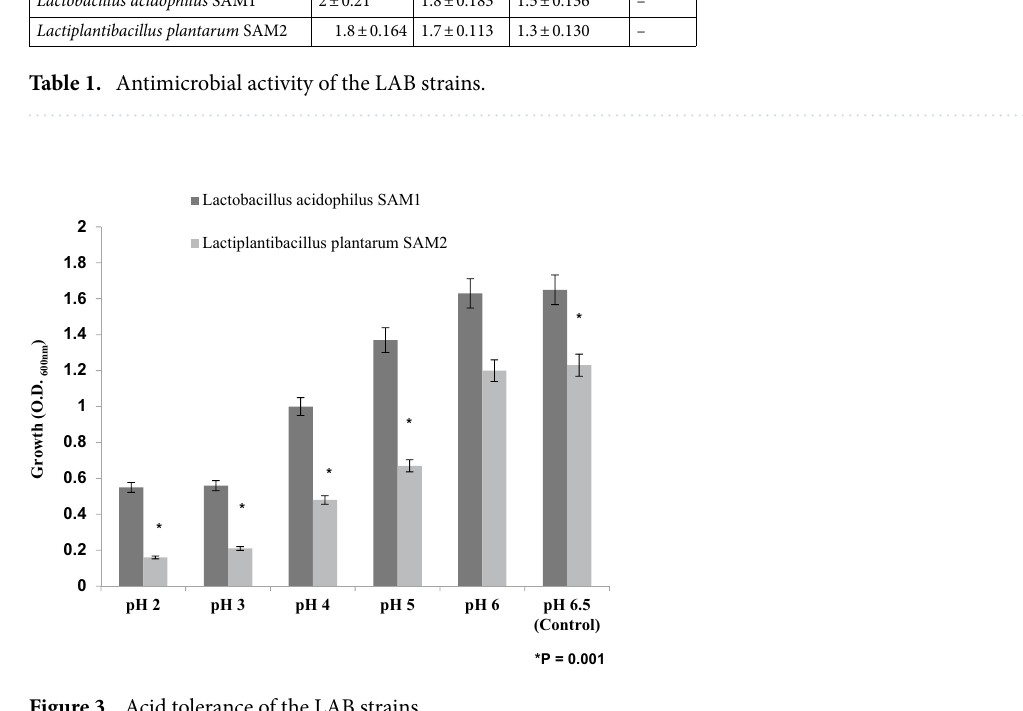
Figure 3. Acid tolerance of the LAB